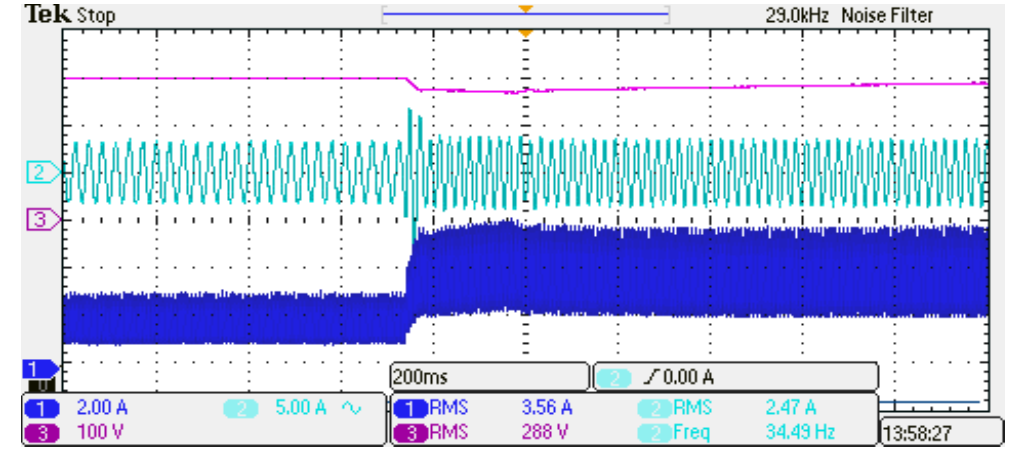
Figure 12. Experimental results at step change from 2A to 4A of the inductor current: ( a ) the proposed Q V/f; ( b ) the conventional L V/f PI-PI (Trace 1: Inductor current, Trace 2: Inverter phase current, Trace 3: DC-link